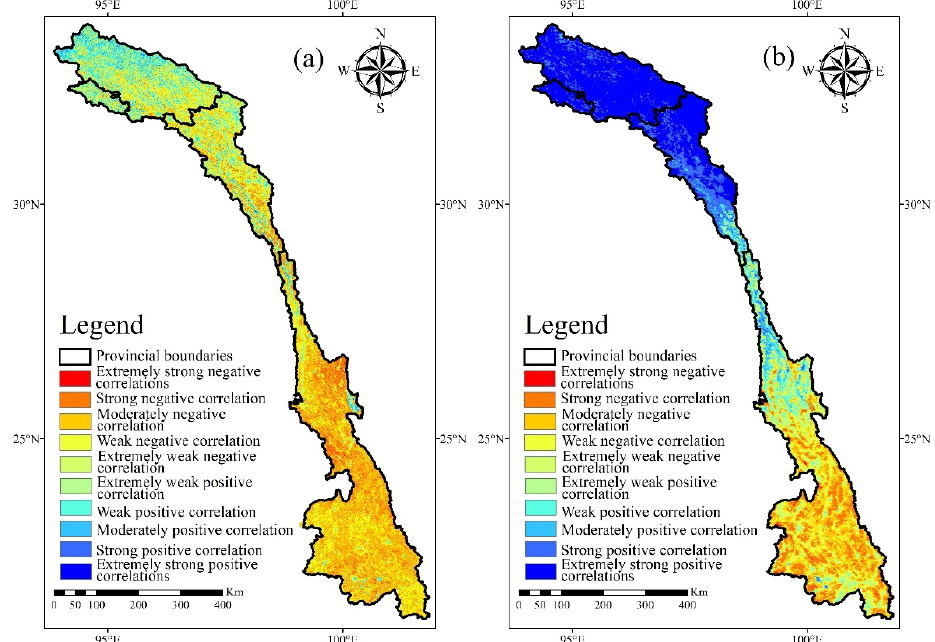
Figure 8. Influence of precipitation and temperature on NDVI. ( a ) Pearson correlation coefficient between NDVI and annual average precipitation, ( b ) Pearson correlation coefficient between NDVI and monthly average temperature.